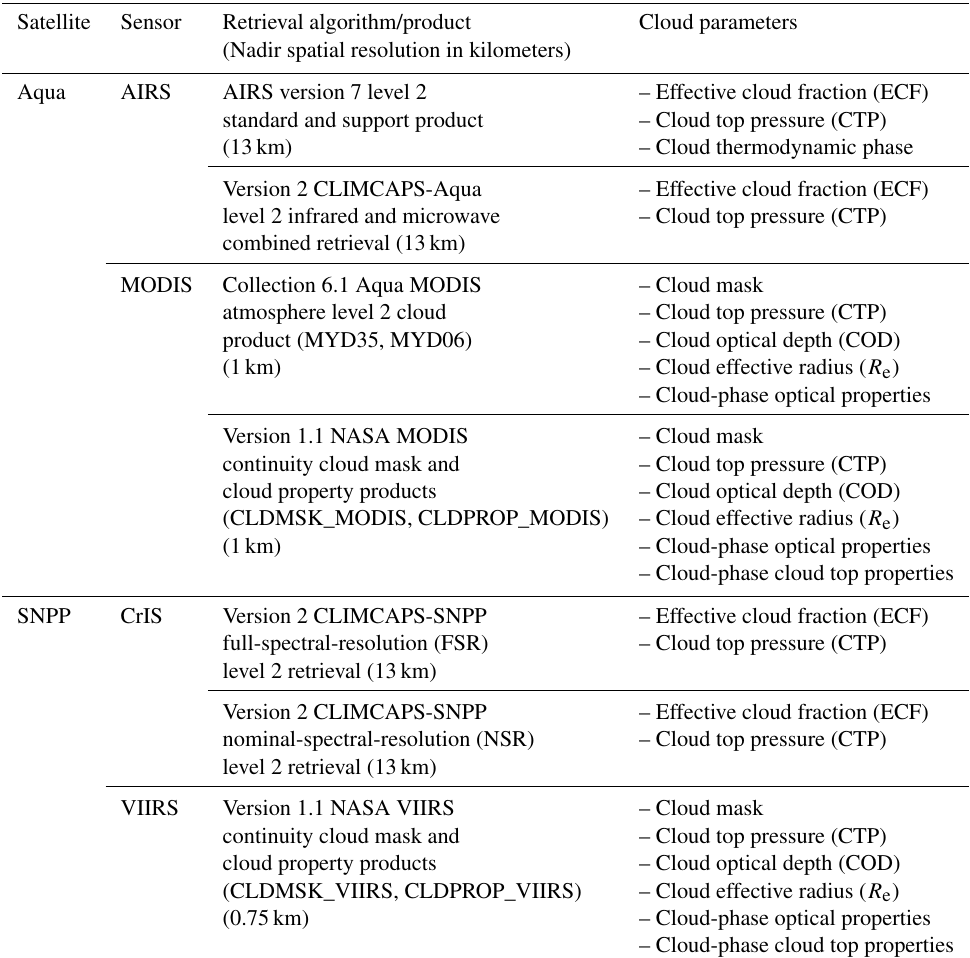
Table 1. The satellite cloud parameters examined in this study and the retrieval algorithms and products from which these parameters are